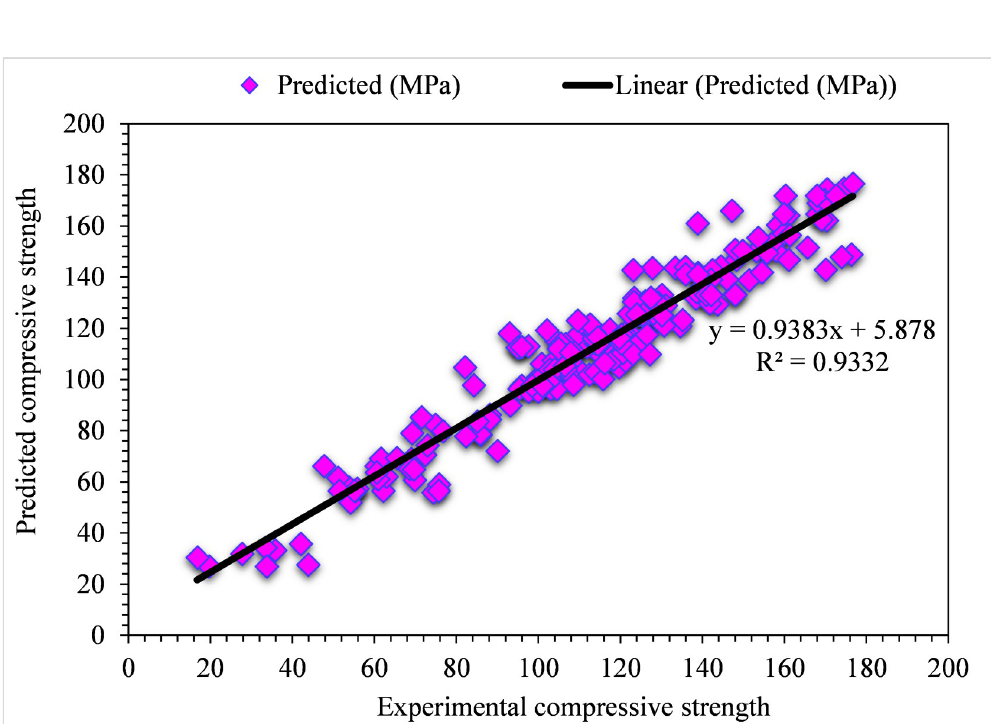
Fig 10. GB predicted and experimental values—UHPC compressive strength.